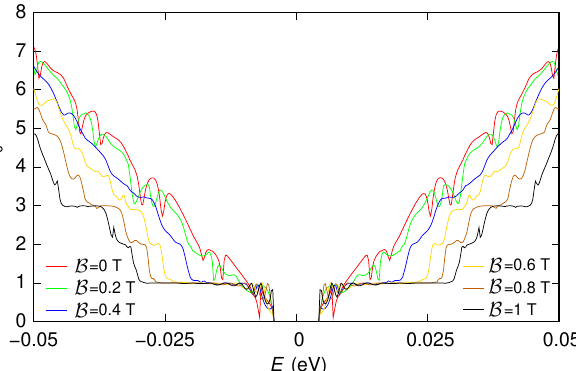
Figure 8. Conductance G , normalized with respect to the conductance quantum G 0 , which was obtained as a function of the Fermi energy E for six values of the orthogonal magnetic field B for the 150 nm-wide and 300 nm-long graphene ribbon with a potential given by the sum of two Lorentzian functions and without including the contacts, using the “second gauge”. These results are not correct, since the absence of contacts limits the number of modes injected into the